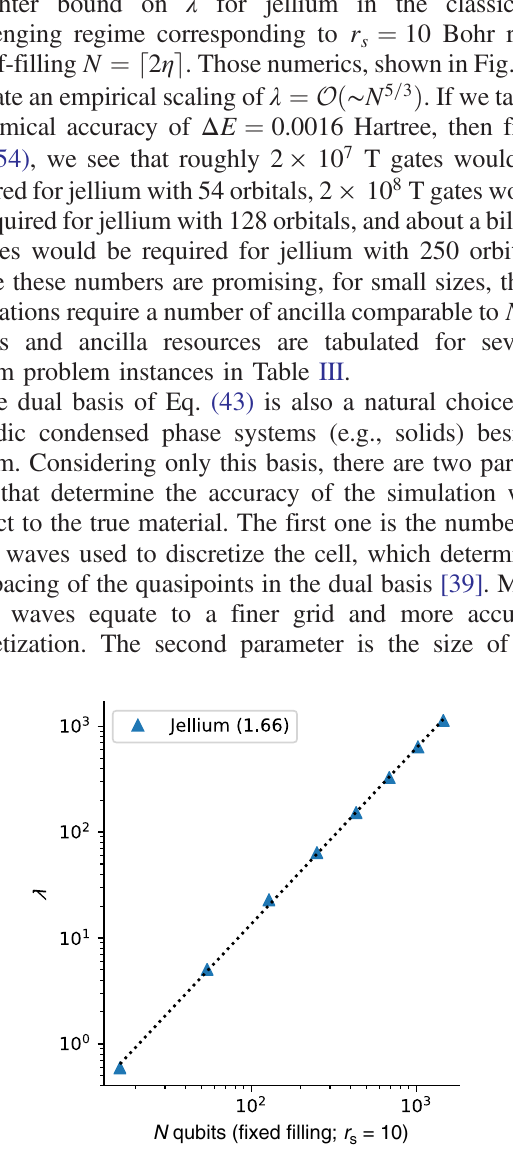
TABLE III. Resources required for quantum simulation of 3D spinful jellium in the dual basis at a Wigner-Seitz radius of 10 Bohr radii, where the cell volume is calculated assuming the system is at half-filling. The units for λ are Hartree. The number of logical ancillae is computed using Eq. (55), and the number of T gates is computed using Eq. (54). These estimates assume (rather conservatively in comparison to classical limitations) that we should target an additive chemical accuracy of Δ E ¼ 0 .